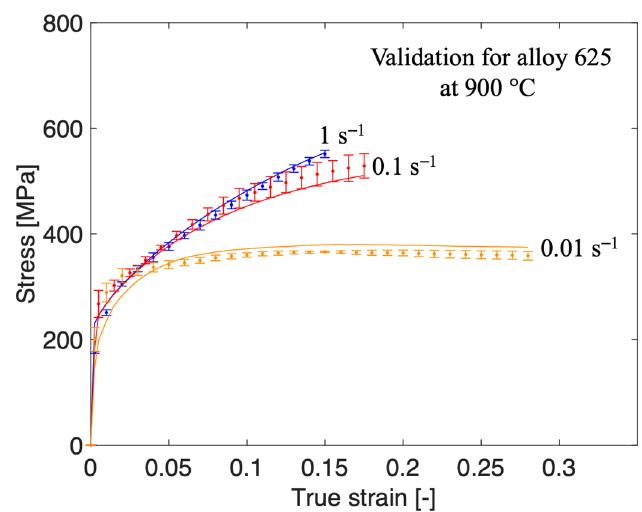
Figure 6. Measured (discrete points with errorbars) and computed (solid lines) flow stress curves at